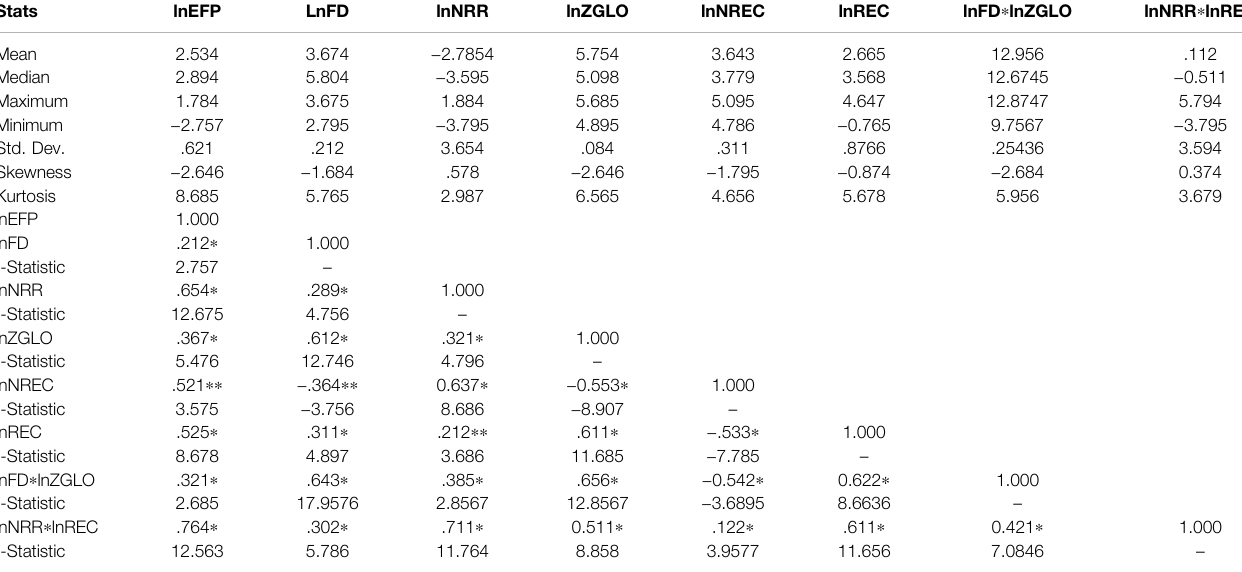
TABLE 1 | Descriptive and inferential statistics of variables.